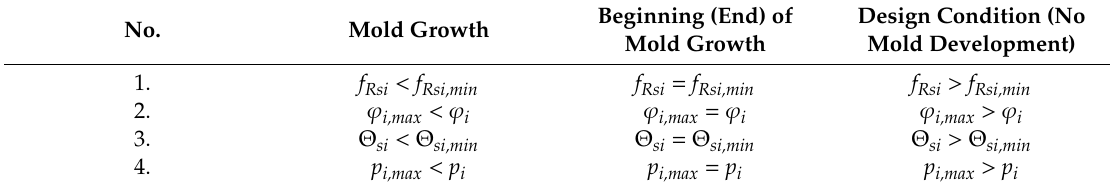
Table 1. Conditions for mold growth on the surface of a building barrier. No. Mold Growth